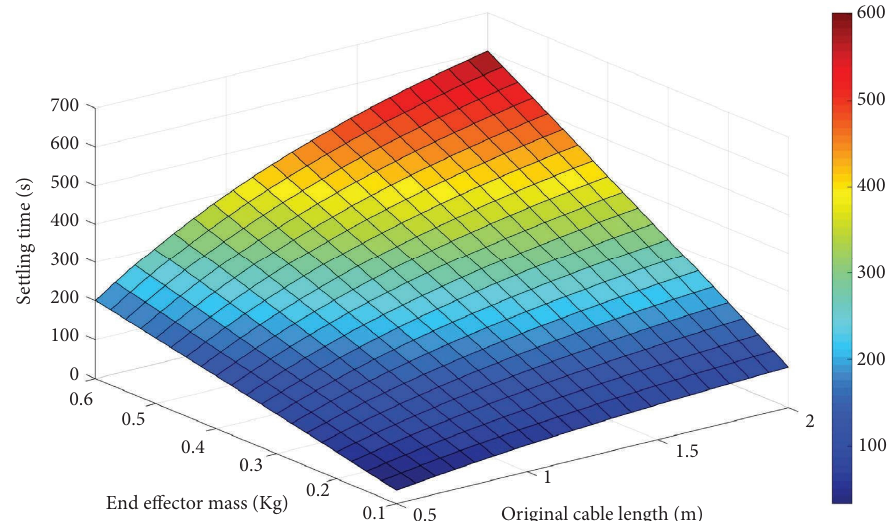
Figure 8: Surface of the settling time response to a change in parameters m